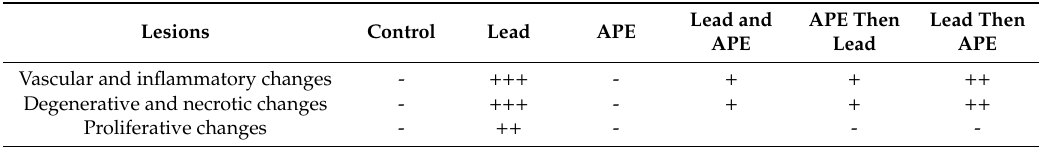
Table 6. Histopathologic changes induced by lead and ameliorative e ff ect of Azolla pinnata ethanolic extract (APE) in hepatic